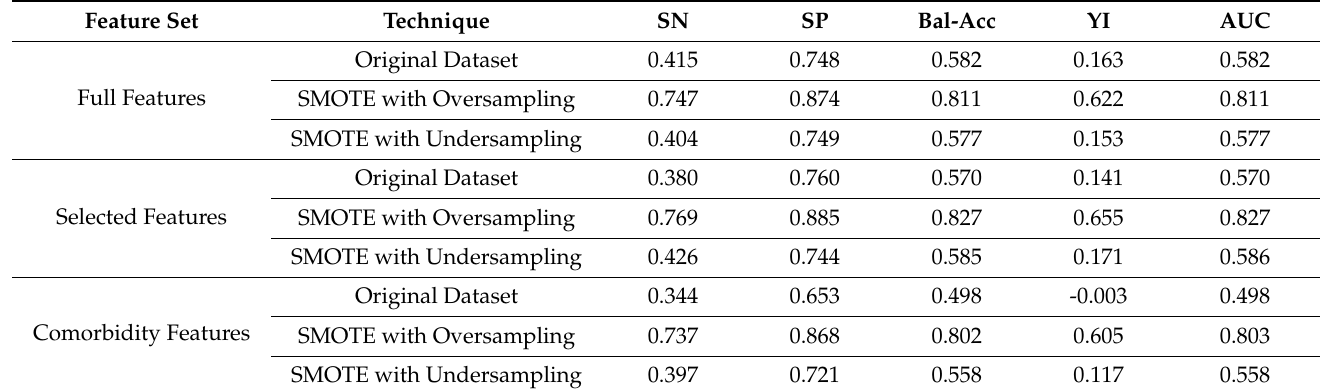
Table A2. Case 2—Decision Tree (Multiclass, No_Ventilator:0, NIV:1, MV:2).